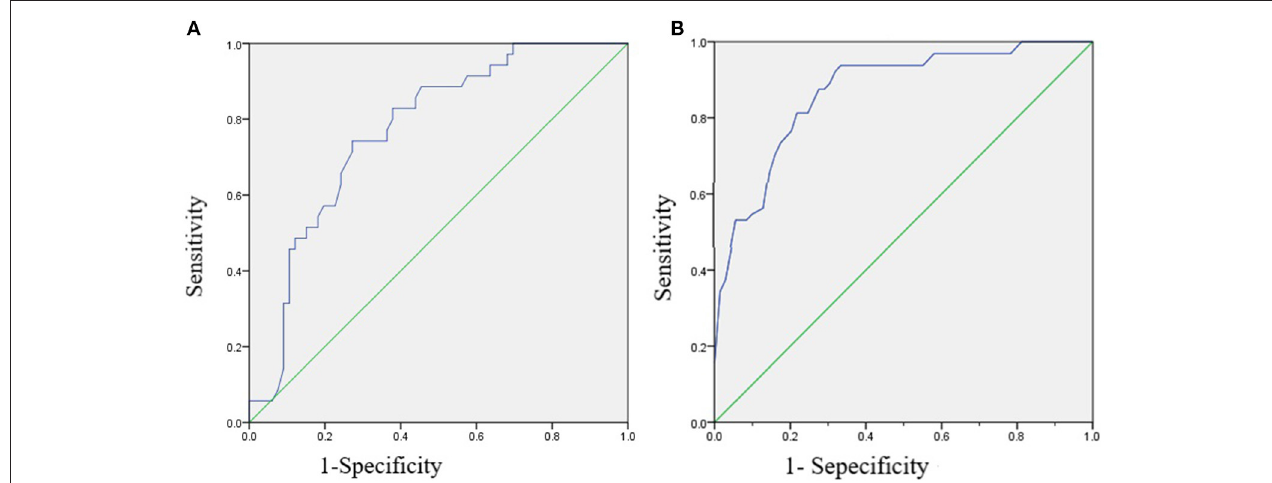
FIGURE 1 | The receiver operating characteristics (ROC) curve of stepwise logistic regression prediction model for adult clinical and academic outcomes in boys with ADHD. (A) The ROC curve of stepwise logistic regression prediction model for adult clinical outcome, with the AUC as 0.770 ( p < 0.001, 95% CI = 0.678–0.863), and the corresponding sensitivity and specificity were 0.743 and 0.727, respectively. (B) The ROC curve of stepwise logistic regression prediction model for adult academic achievement, with the AUC as 0.870 ( p < 0.001, 95% CI = 0.796–0.944), and the corresponding sensitivity and specificity was 0.813 and 0.783,